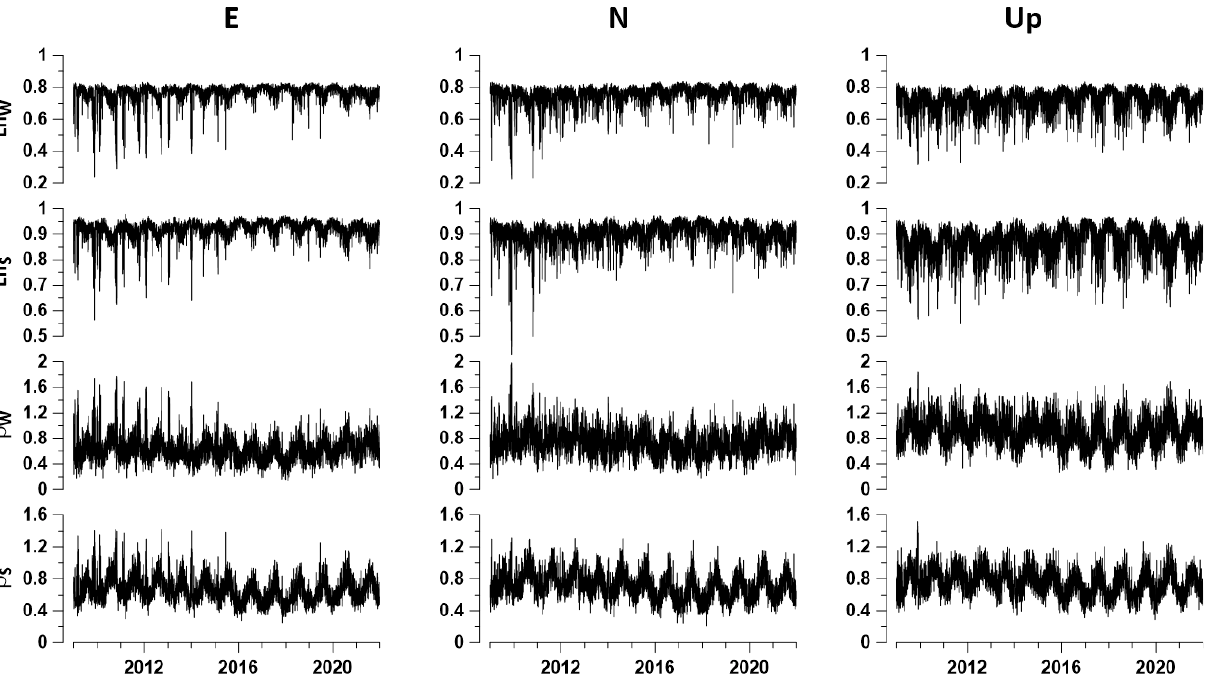
Figure 2. Plots of daily values for four GPS ground tremor properties for reference point number 8 for three ground displacement components E, N, and Up. The property values are calculated as medians from the ten nearest operable stations.